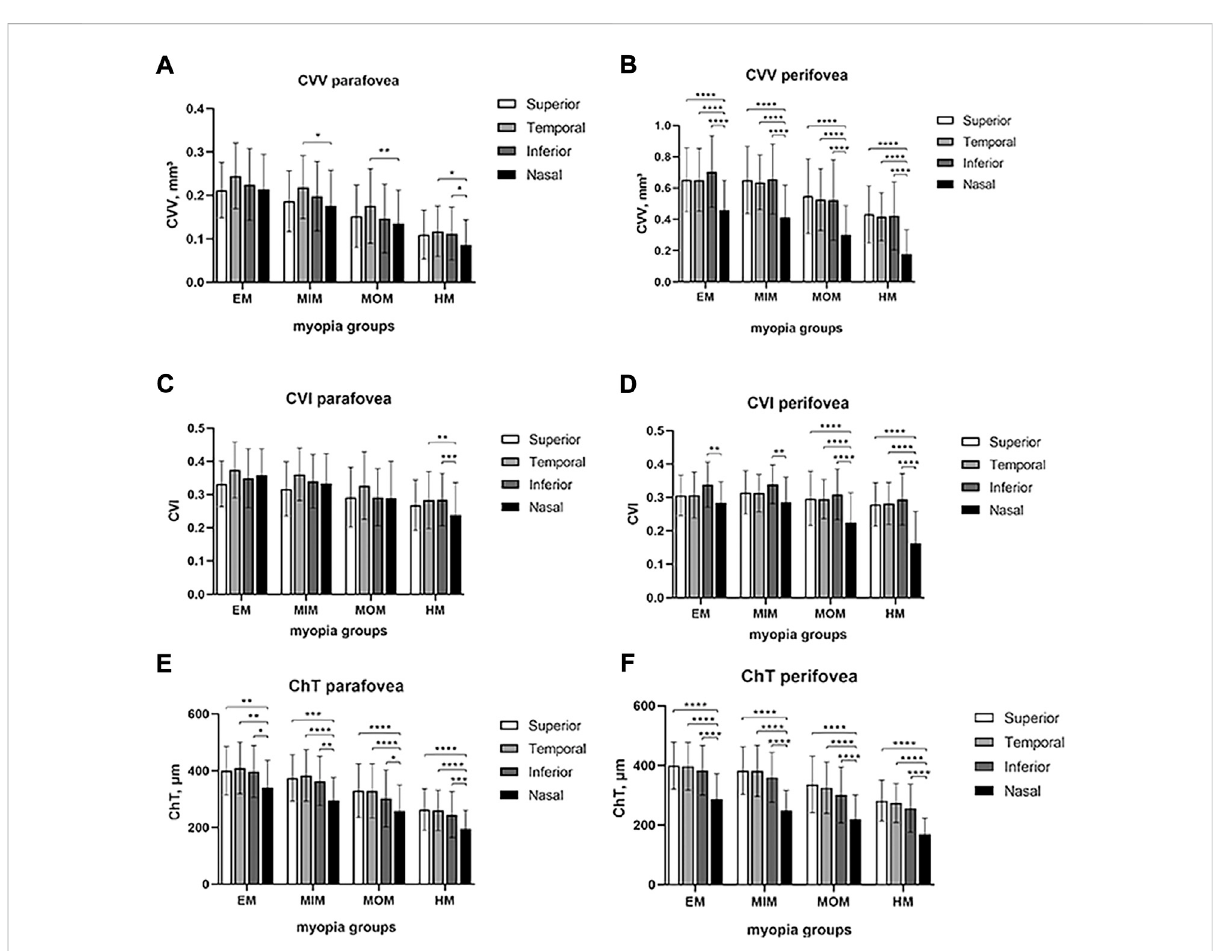
FIGURE 3 Comparison of CVV, CVI, and ChT in macular regions among four quadrants of different myopic groups. (A) CVV in the parafovea region. (B) CVV in the perifovea region. (C) CVI in the parafovea region. (D) CVI in the perifovea region. (E) ChT in the parafovea region. (F) ChT in the perifovea region. Statistical signi fi cance was marked as * ( p < 0.05), ** ( p < 0.01), *** ( p < 0.001), and **** ( p < 0.0001). EM, emmetropia; MIM, mild myopia; MOM, moderate myopia; HM, high myopia; CVV, choroidal vessel volume; CVI, choroidal vessel index; ChT, choroidal